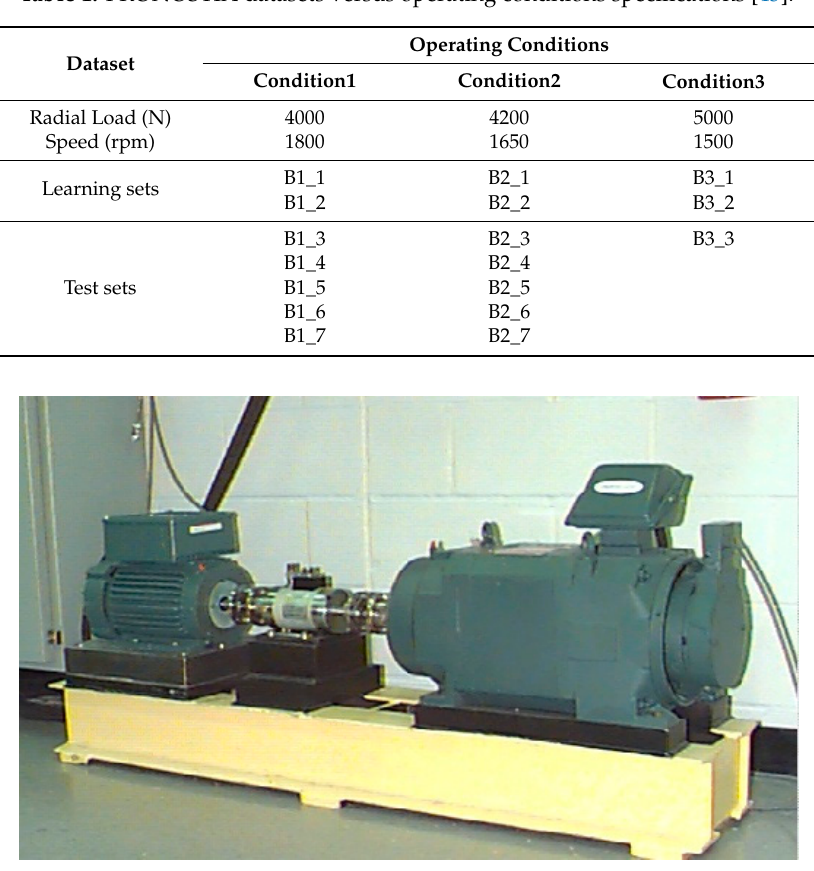
Figure 12. Overview of the CWR Bearing Data Center platform [45].